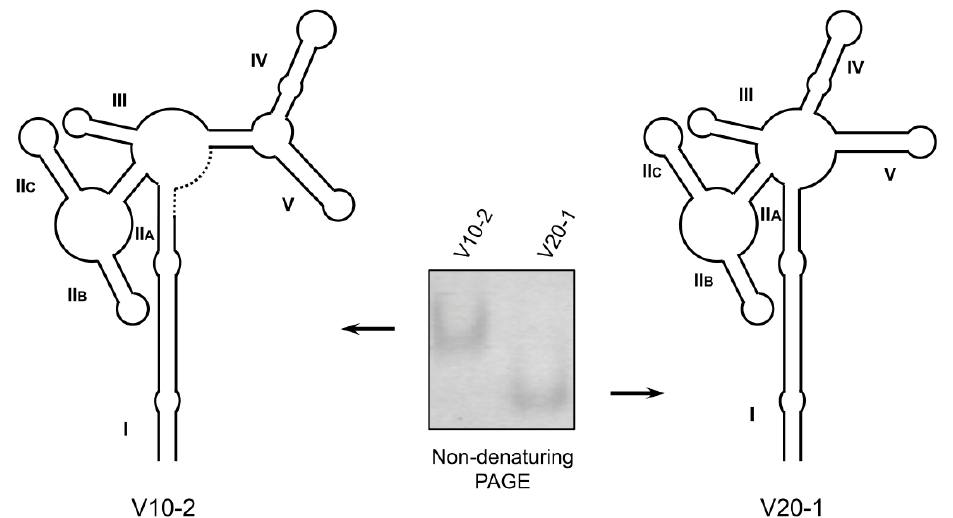
Figure 6. Patient-derived HIV-1 RREs from early and late time-points post-infection exhibit different secondary structures. Secondary structures of V10-2 RRE (an early isolate, (left) and V20-1 RRE (a late isolate, (right) determined by SHAPE-MaP. ( Center) differential migration rate of V10-2 and V20-1 RRE, following non-denaturing PAGE and UV shadowing, is suggestive of alternate conformers/ Adapted from Sherpa et al. [59].